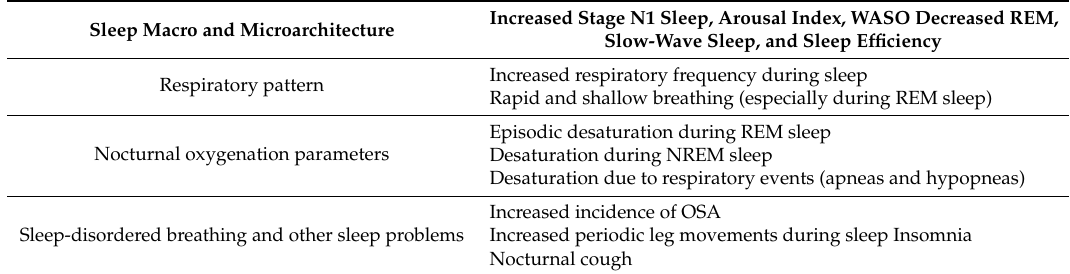
Table 2. Sleep disorders in